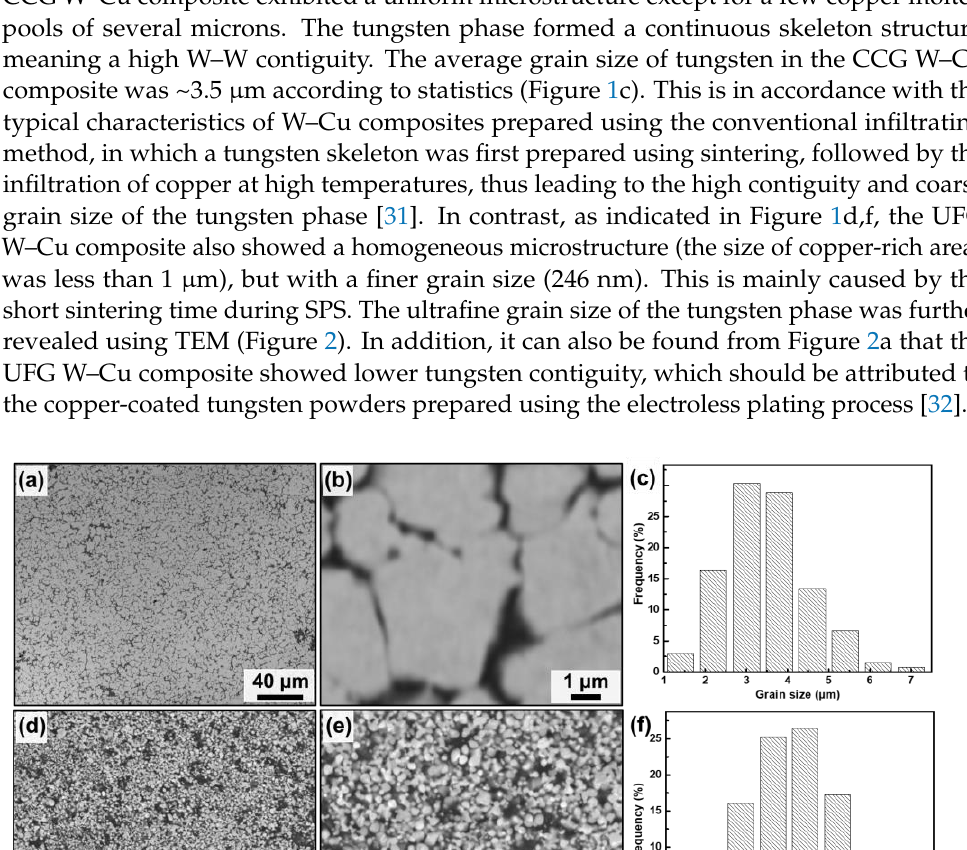
Figure 2. TEM bright field image ( a ) and high-resolution TEM images ( b , c ) of the UFG W – Cu com- posite, inserts in ( b , c ) are the corresponding fast Fourier transformation patterns. Table 1. Properties of the CCG W – Cu and UFG W – Cu composites. W – Cu